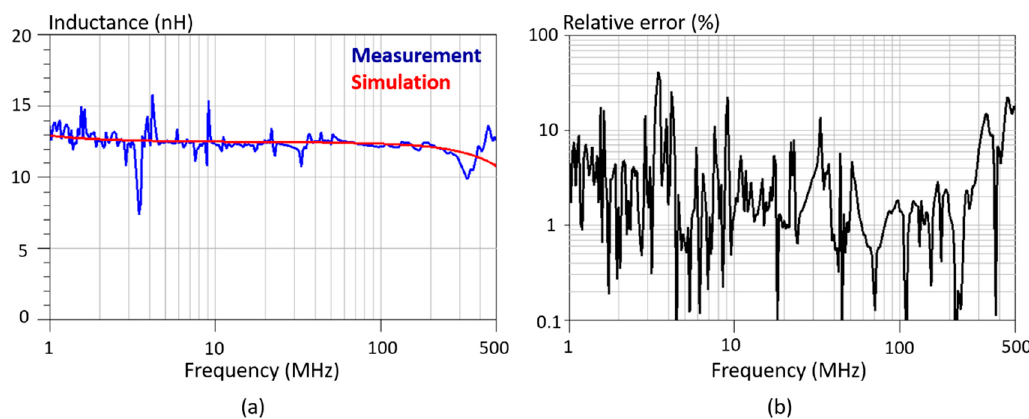
Figure 17. Lateral commutation loop inductance extraction: ( a ) measurement vs. simulation; ( b ) relative error.